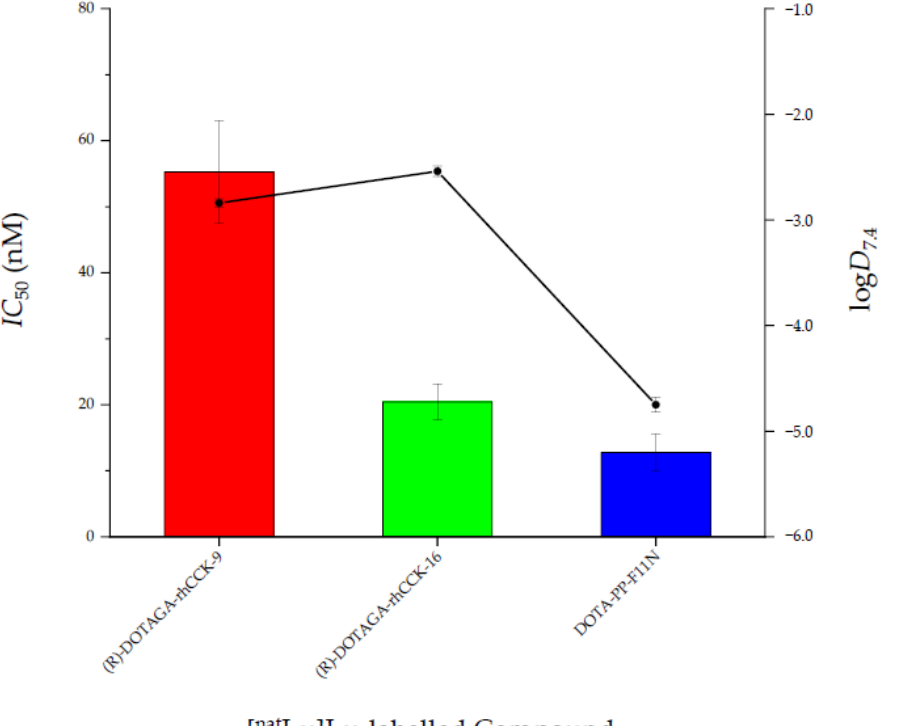
Figure 6. Affinity ( IC 50 ) and lipophilicity (log D 7.4 ) data of nat/177 Lu-labelled rhCCK ligands, ( R )-DOTAGA-rhCCK-9 and -16, as well as DOTA-PP-F11N. Hence, [ 177 Lu]Lu-( R )-DOTAGA-rhCCK-9 and -16 showed 3- and 8-fold higher activity levels in the tumour, respectively, than the reference ligand at 24 h p.i. Similar observations were made for stomach levels due to the endogenous CCK-2R expression in this 2R-mediated internalisation than [ 177 Lu]Lu-DOTA-PP-F11N, which points to an enhanced